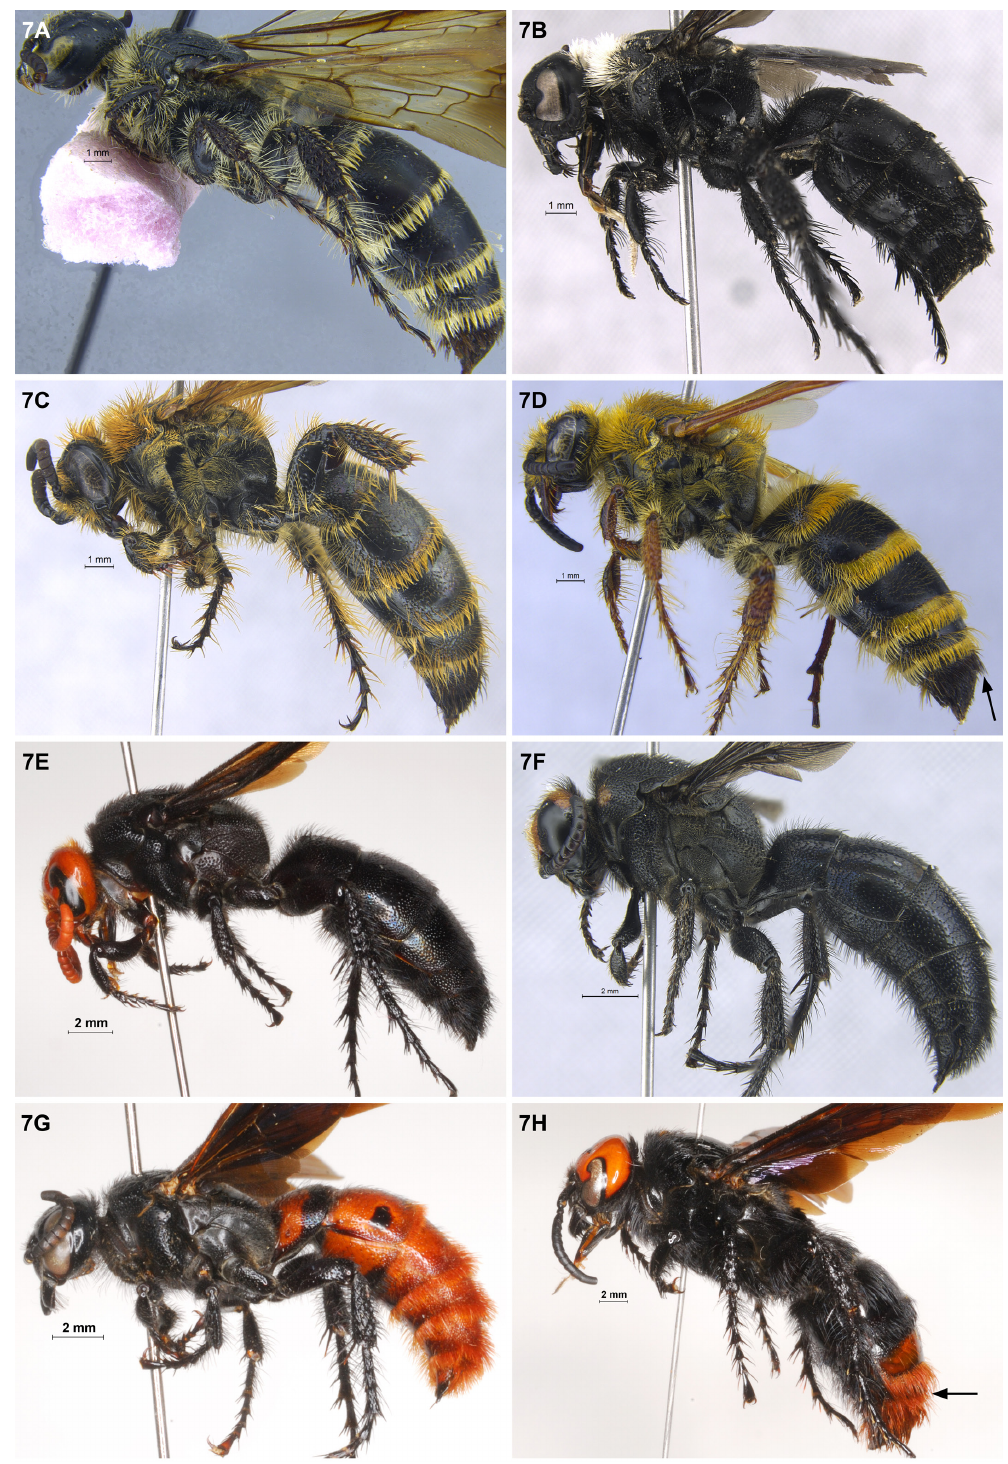
Fig. 7. Females, lateral habitus. A . Campsomeriella annulata annulata (Fabricius, 1793). B . Camps. collaris (Fabricius, 1775). C . Megacampsomeris formosensis chinensis Betrem, 1941. D . Phalerimeris phalerata phalerata (de Saussure, 1858). E . Austroscolia ruficeps ruficeps (Smith, 1855). F . Carinoscolia junnanensis (Betrem, 1928). G . Liacos erythrosoma (Burmeister, 1854). H . Megascolia azurea (Christ,